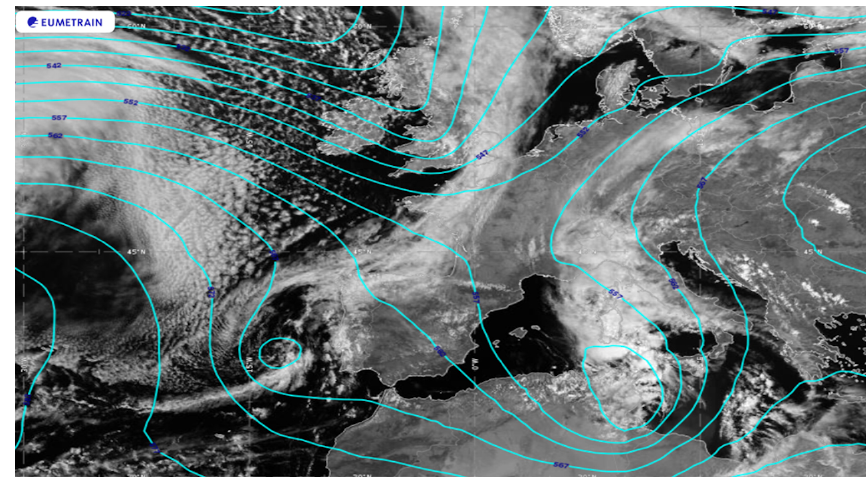
Figure 1. ECMWF analysis: geopotential height at 500hPa (cyan lines, contour lines 5 dam) and visible satellite image on 2 May 2018 at 12:00UTC. Image retrieved from Eport portal – EUMeTrain.